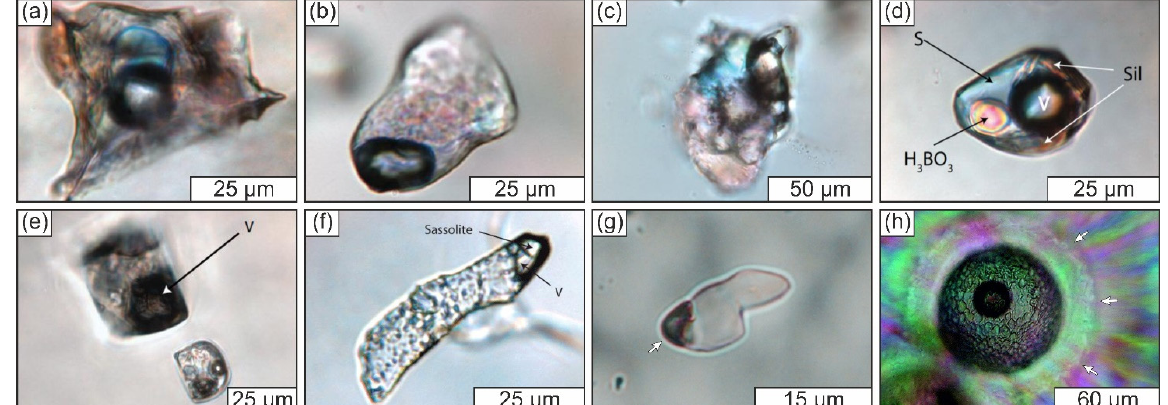
Figure 3. Examples of supposed inclusions of hydrosilicate fluids and some associated inclusions. ( a – f ) Inclusions in minerals from the Malkhan pegmatites (Russia) reported in [62]. ( a – c ) Quartz- hosted type-A melt inclusions in the interpretation of [62]. Identical inclusions were classified as melt or fluid–melt inclusions in [59,60], and as inclusions of recrystallised gels that represent remnants of hydrosilicate fluids in [5,61]. ( d , e ) Quartz-hosted type-B ( d ) and type-C ( e ) melt inclusions according to [62]. Such inclusions were classified as fluid inclusions by [59–61]. S: solution; H 3 BO 3 : sassolite crystal; Sil: silicate minerals; V: vapour bubble. ( f ) A tourmaline-hosted gel-like inclusion according to [62]. Everything except the sassolite crystal and vapour bubble in these inclusions consists of SiO 2 phases comprising quartz, cristobalite and moganite. V: vapour bubble. ( g ) An inclusion of quartz in topaz from greisens of the St. Austell granite (UK) that was interpreted to represent remnants of a SiO 2 -rich colloid [3,18,19]. The arrow highlights a proposed shrinkage bubble. The image was kindly provided by B. Williamson. ( h ) Inclusions in chalcedony from the Iceland spar deposits on the Nizhnyaya Tunguska river reported in [67], which are identical to inclusions described in [51]. According to both studies, the entire field of view was initially a silica gel, and the inclusion in the middle was formed by expulsion of a syneresis liquid from that gel (which on its own represents a silica sol [67]). Arrows indicate the outer boundary of a dehydrated SiO 2 layer that represents part of the inclusion. The image was kindly provided by V. Prokofiev and reproduced with a permission from the editorial office of Geology.